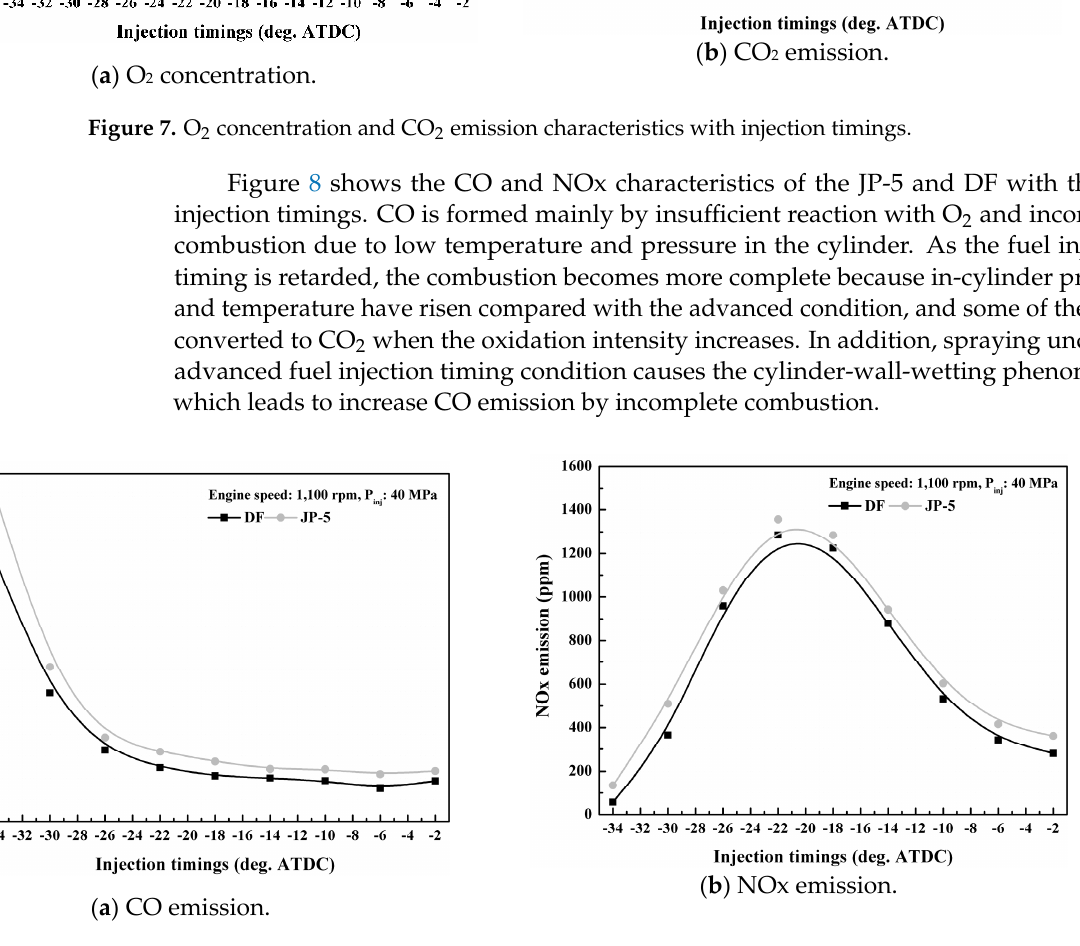
Figure 8. CO and NOx emission characteristics with injection timings .